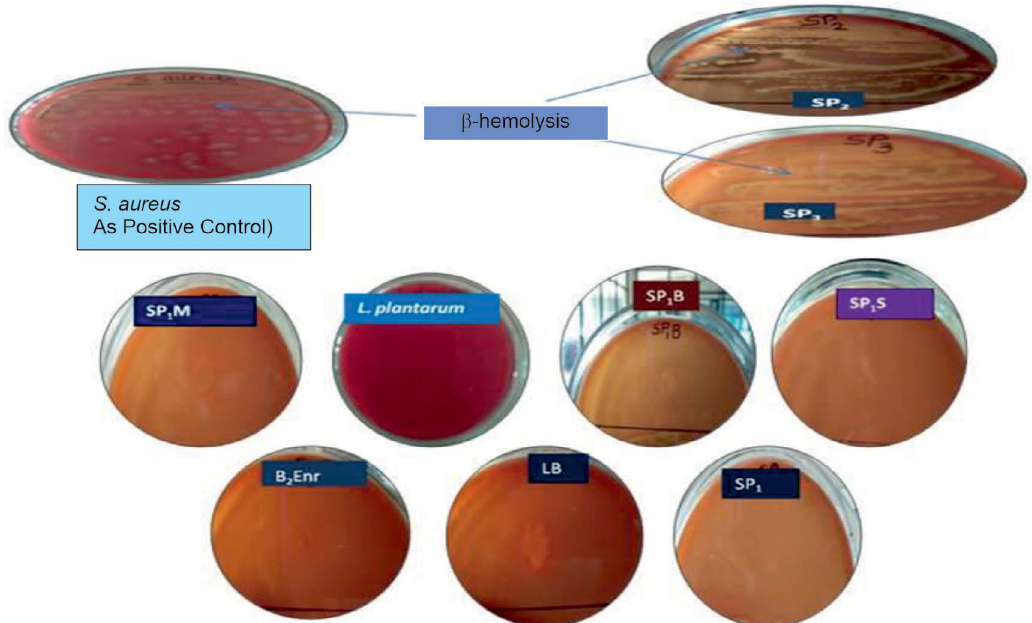
Fig. 2. Hemolytic activity of probiotic isolates: SP2 & SP3 showed b -hemolysis. S. aureus was used as positive control culture for b